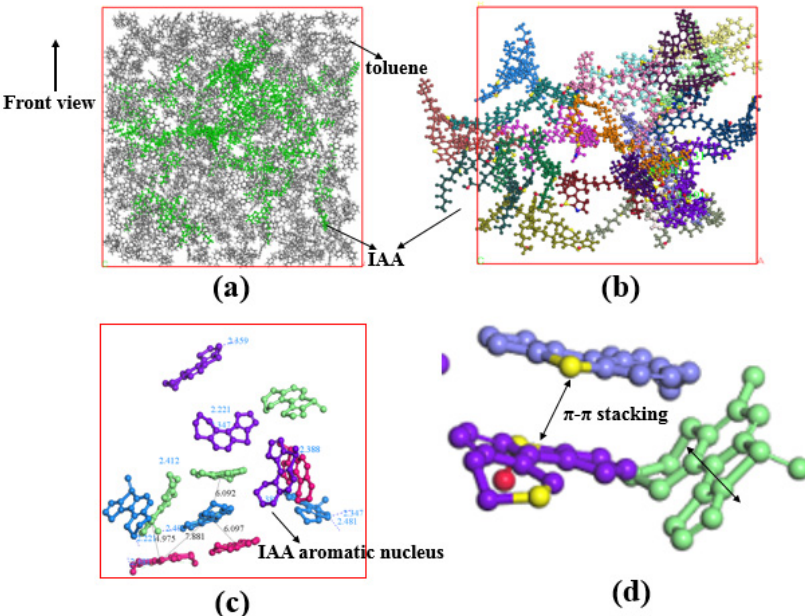
Figure 26. Aggregated system of IAA containing heteroatom (( a ): initial configuration, ( b ): toluene molecules were hidden, ( c ): hydrogen atoms and fat chain were hidden (the blue number represents the hydrogen bond distance, the black number represents the π – π bond distance, unit is Å), ( d ):